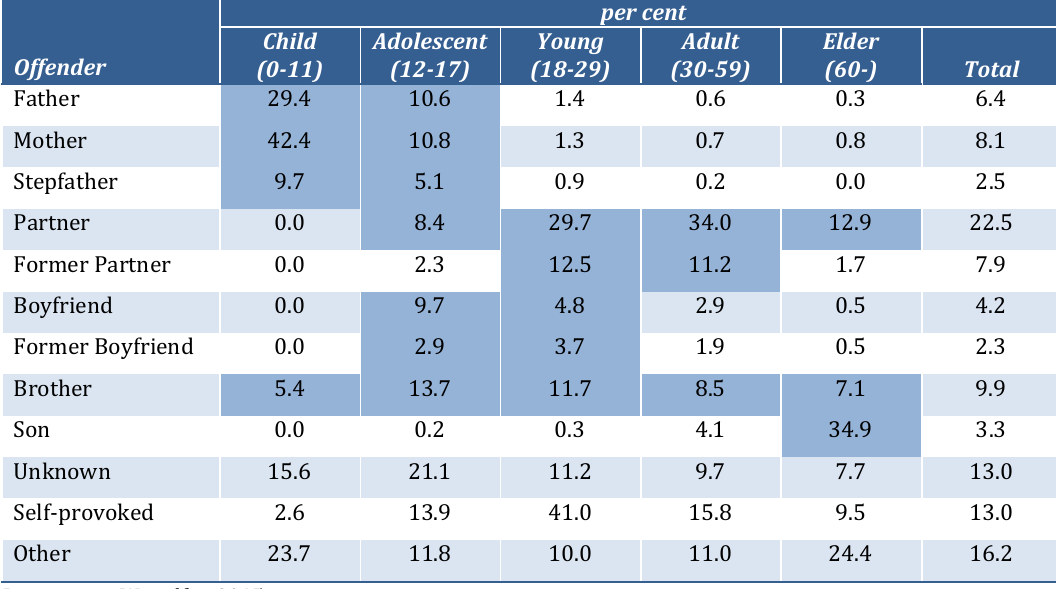
per cent Child Adolescent Young Adult Elder (0 ‐ 11) (12 ‐ 17) (18 ‐ 29) (30 ‐ 59) (60 ‐ ) Total